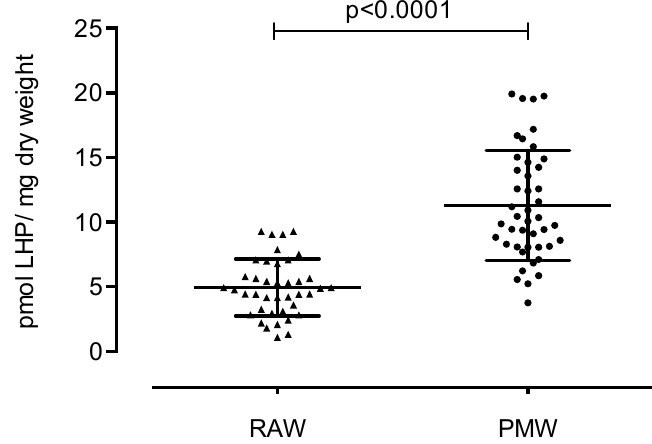
Figure 2. Values of the second stage of lipoperoxidation in reproductive-aged women (RAW) and postmenopausal women (PMW).